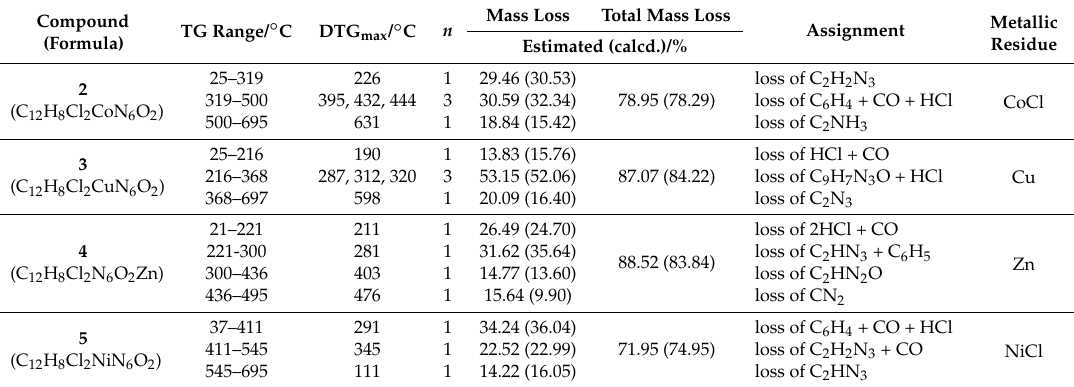
Table 2. Thermoanalytical results (TGA and DTG) for the CPs.